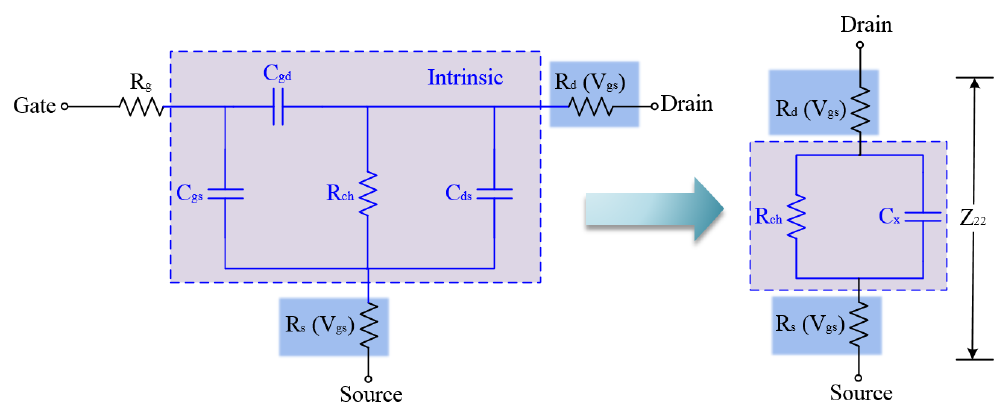
Figure 1. Small signal equivalent circuits used for extraction. Equivalent circuit of pHEMT in strong inversion at V ds = 0 V (left). Simplified circuit for calculation of Z 22 (right).